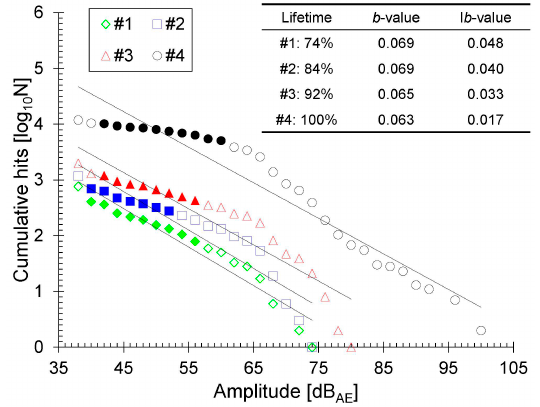
Figure 9. Example cumulative hits and I b -values.